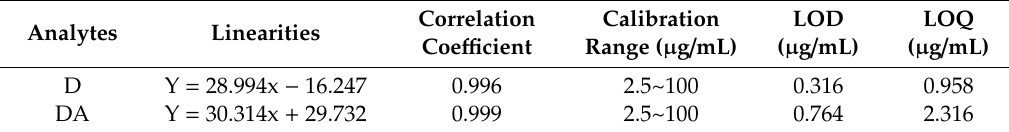
Table 9. Linear ranges, correlation coe ffi cients, LOD, and LOQ of calibration